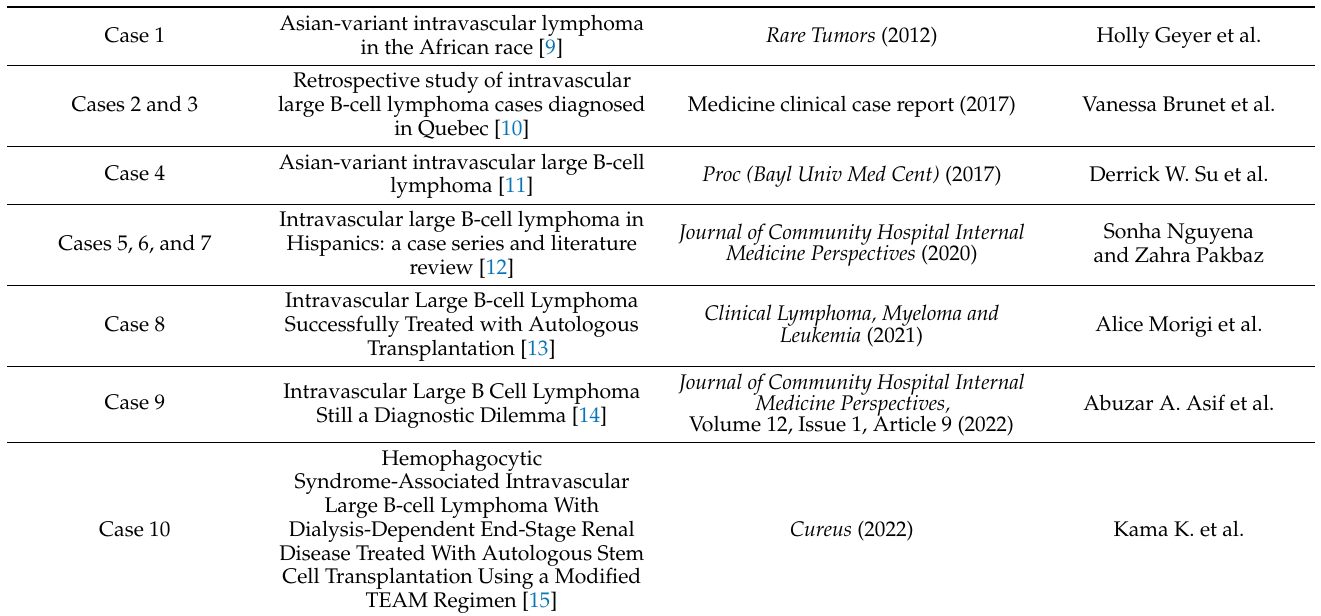
Table 3. Cases of the hemophagocytic variant of IVLBCL described in the Western Hemisphere in Caucasian, Hispanic, and African